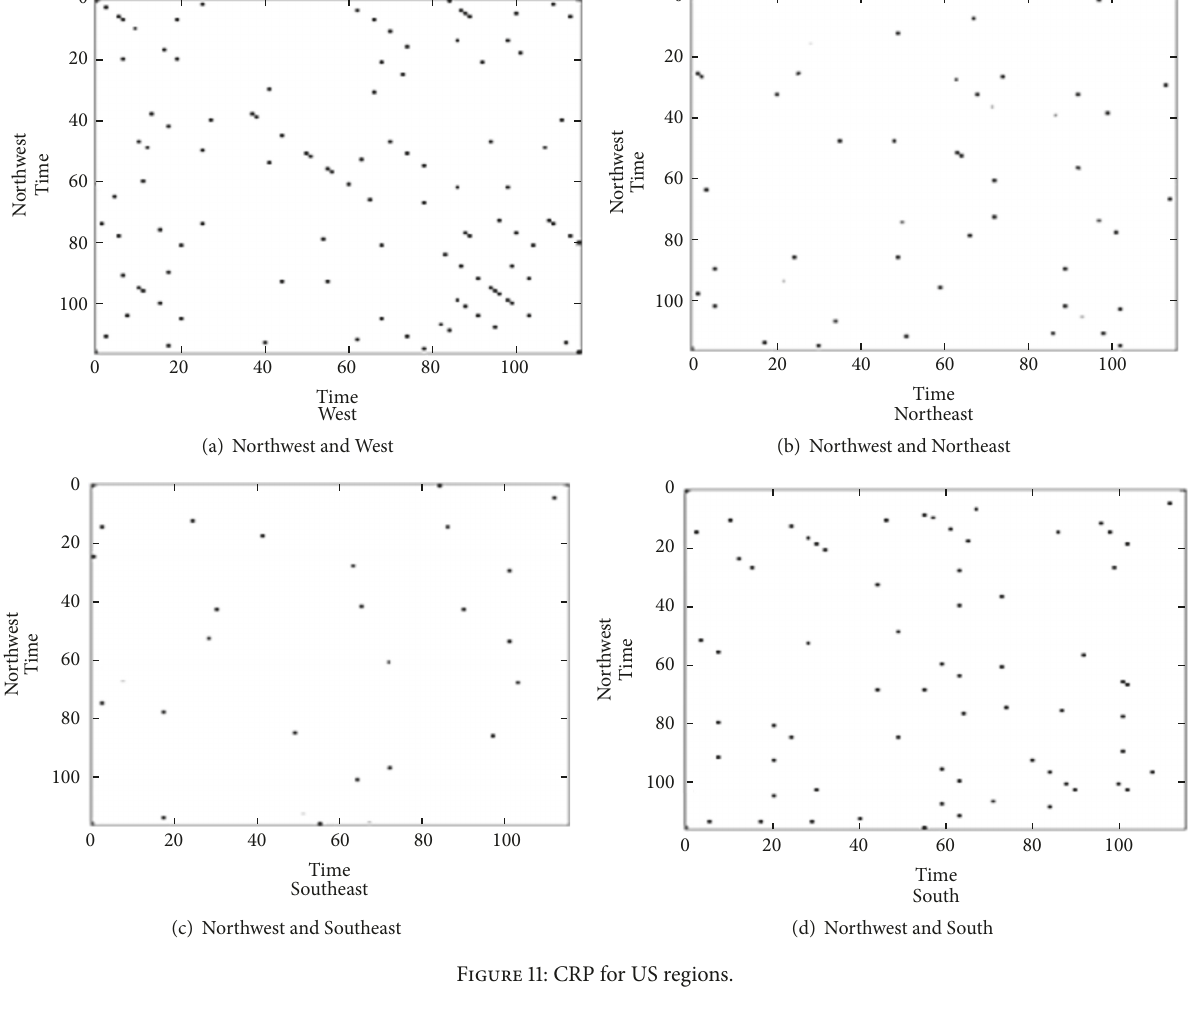
Figure 11: CRP for US regions.